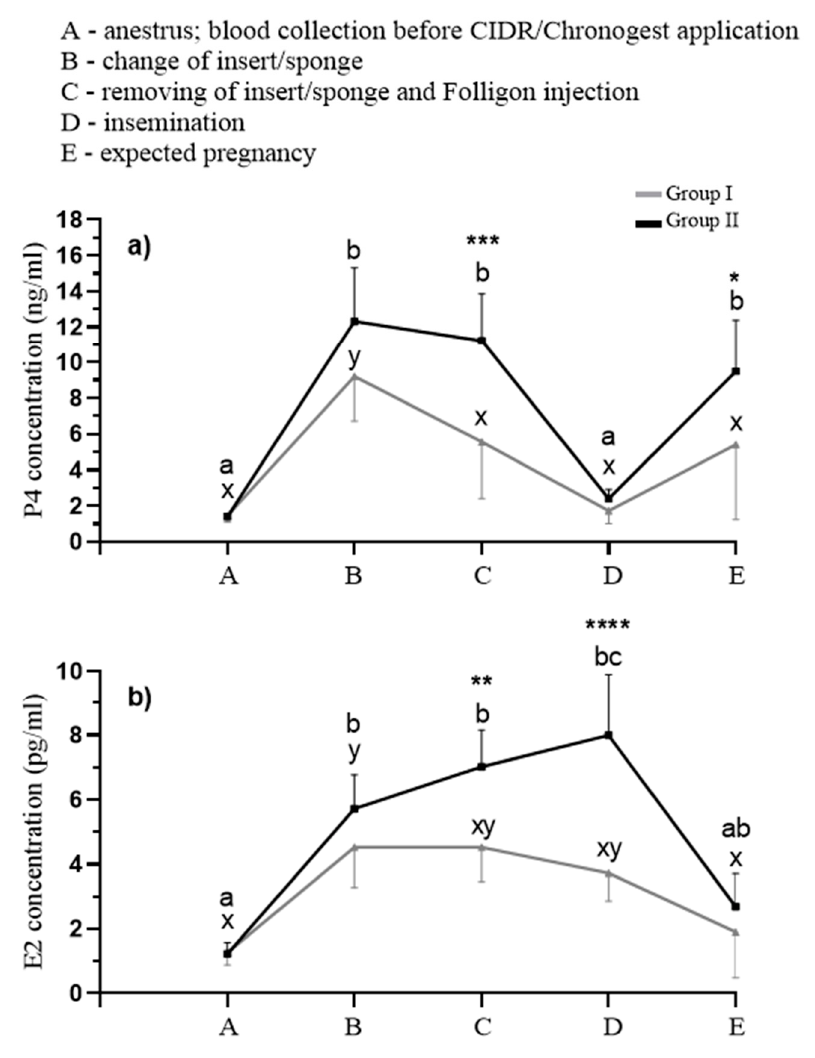
Figure 1. Concentrations of progesterone ( a ; ng/mL) and 17-beta estradiol ( b ; pg/mL) in the blood. Different letters among Group I (a–c) and Group II (x-y) indicate statistical differences in hormone concentrations, whereas asterisks indicate statistical di ff erences between selected points (A–E) between Group I and Group II. p < 0.05 was considered significant. * p < 0.05, ** p < 0.01, *** p < 0.001, **** p <